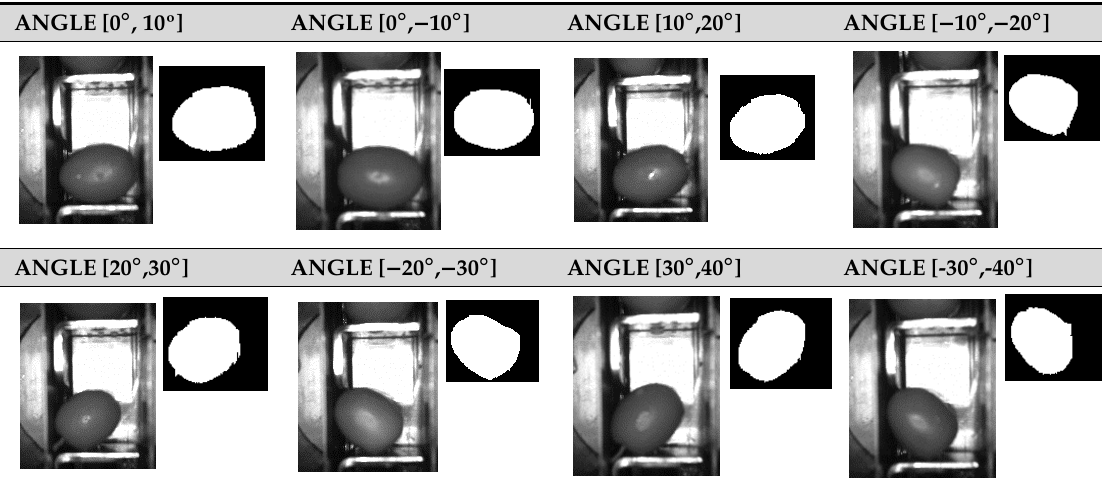
Table 1. Images (both original and binarized) classified according to angular intervals.